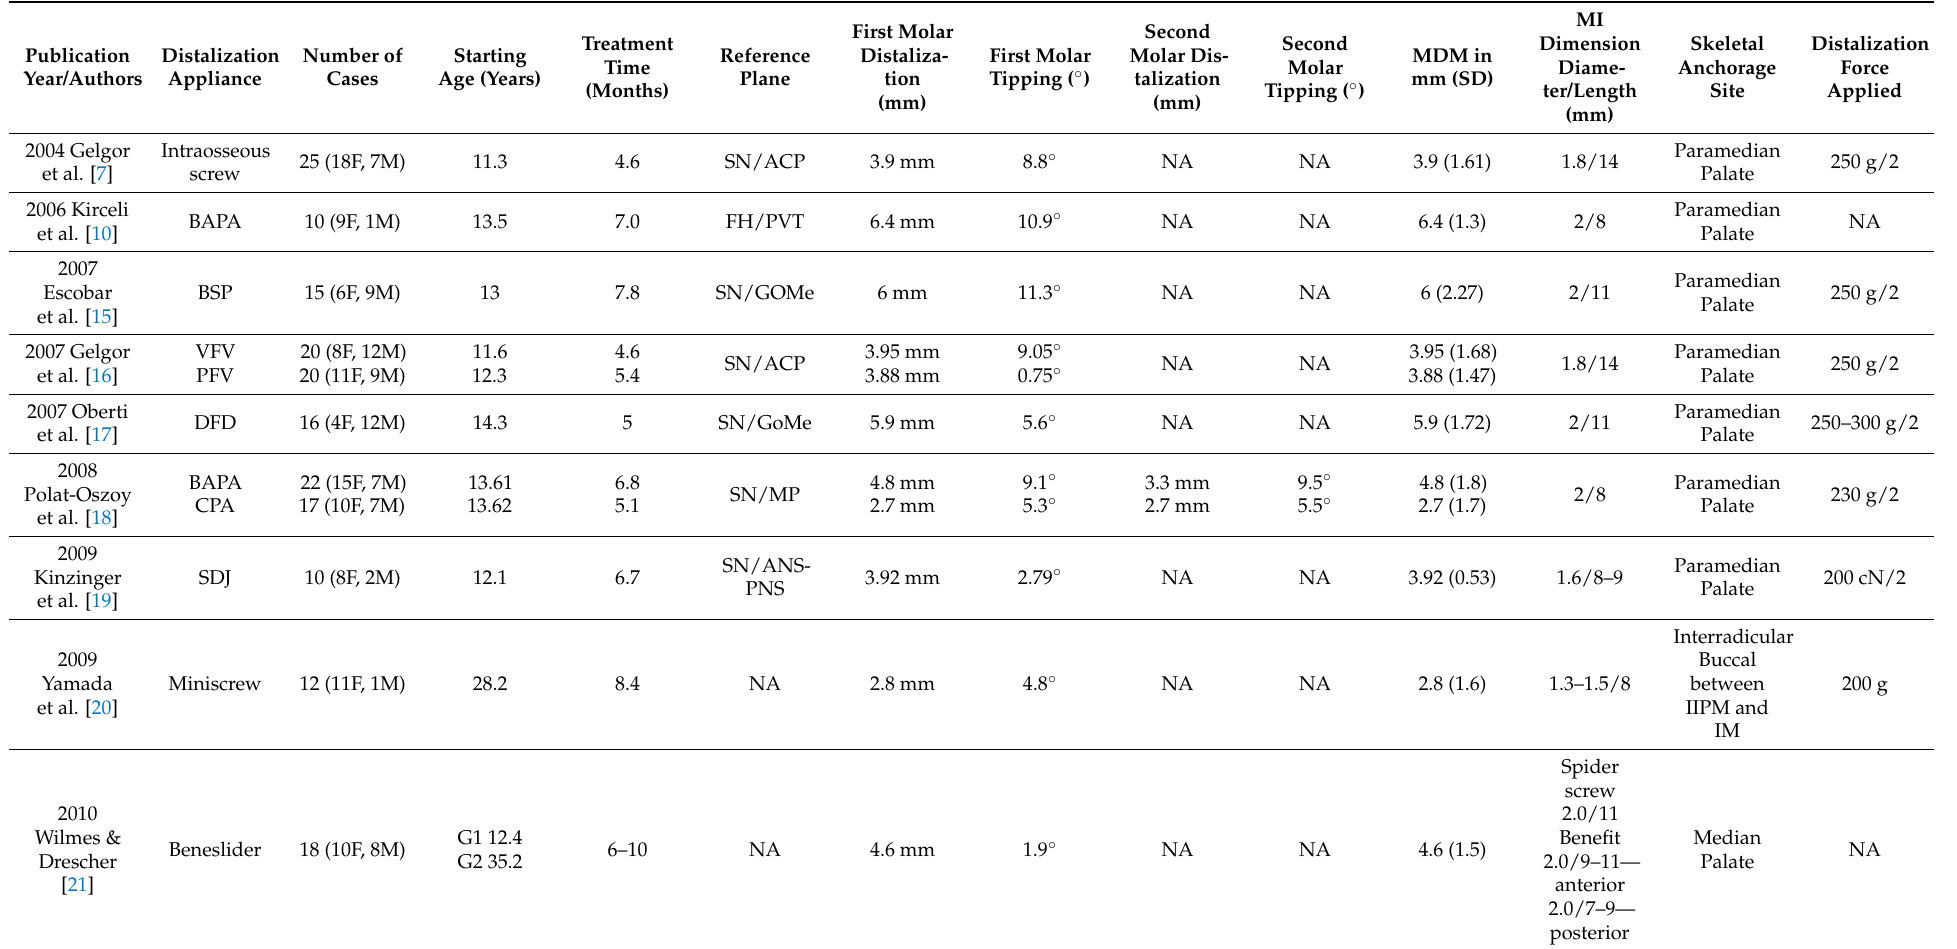
Table 1. Characteristics of the included